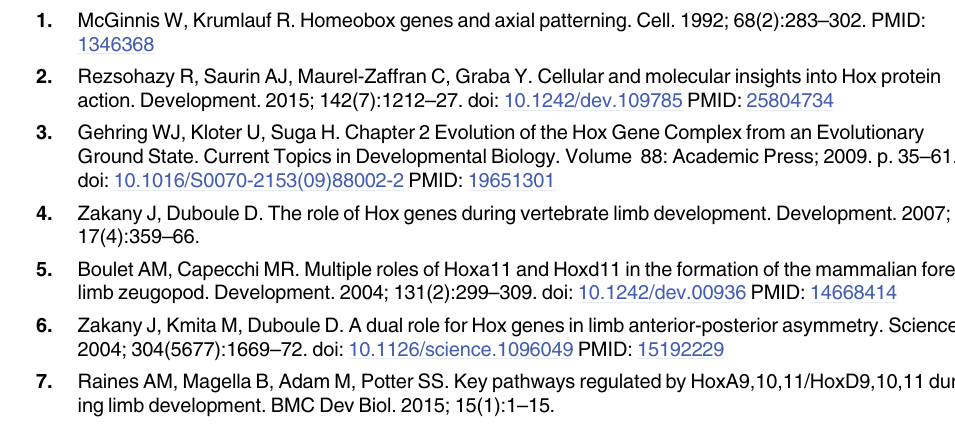
S1 Table. RNA-seq raw read counts for every annotated gene from the HOX overexpres- sing chMM cultures and a control chMM culture, in